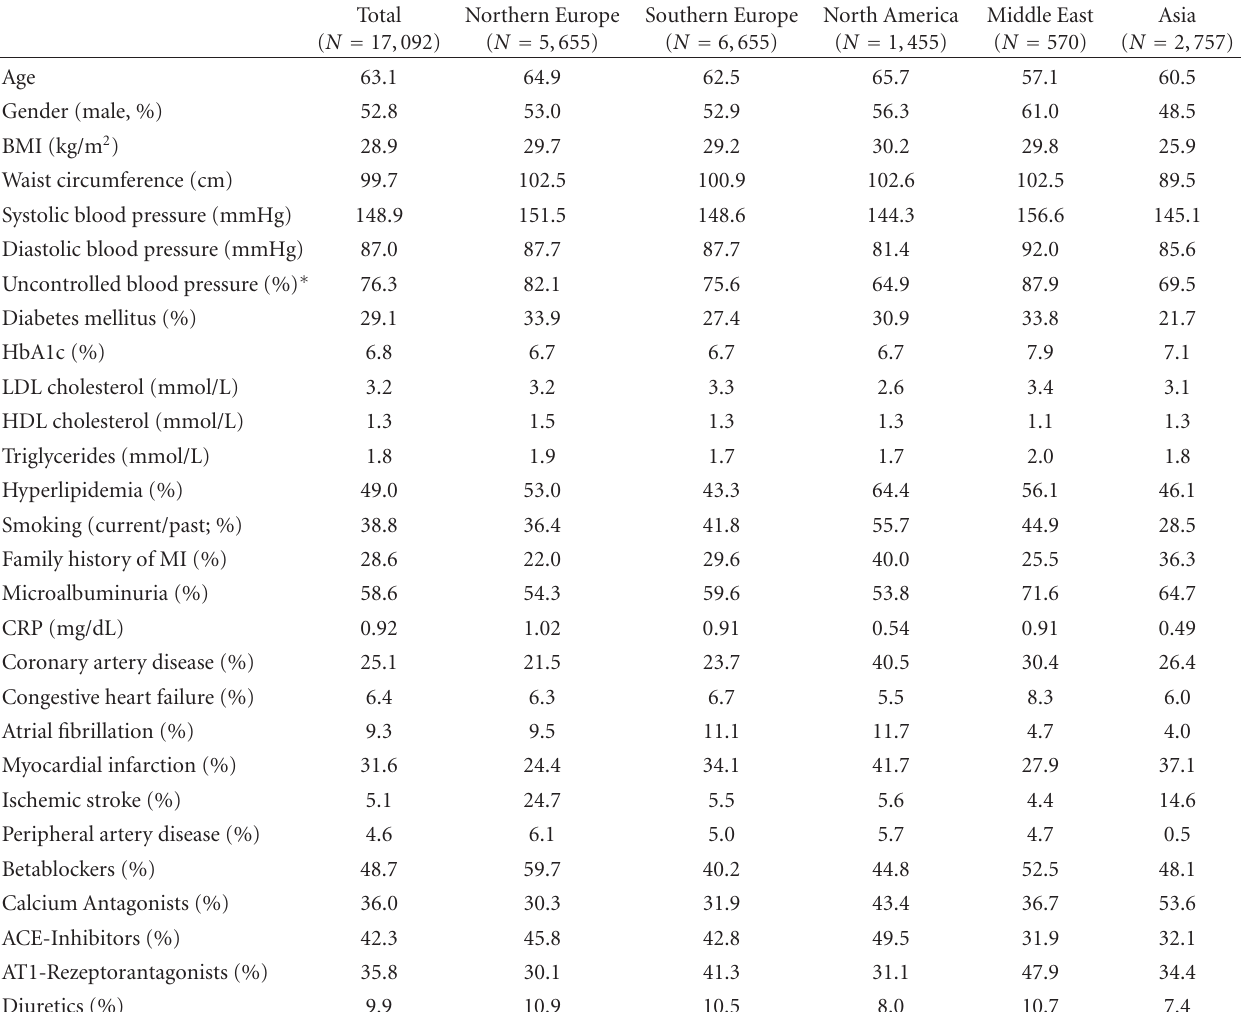
Table 1: Patient